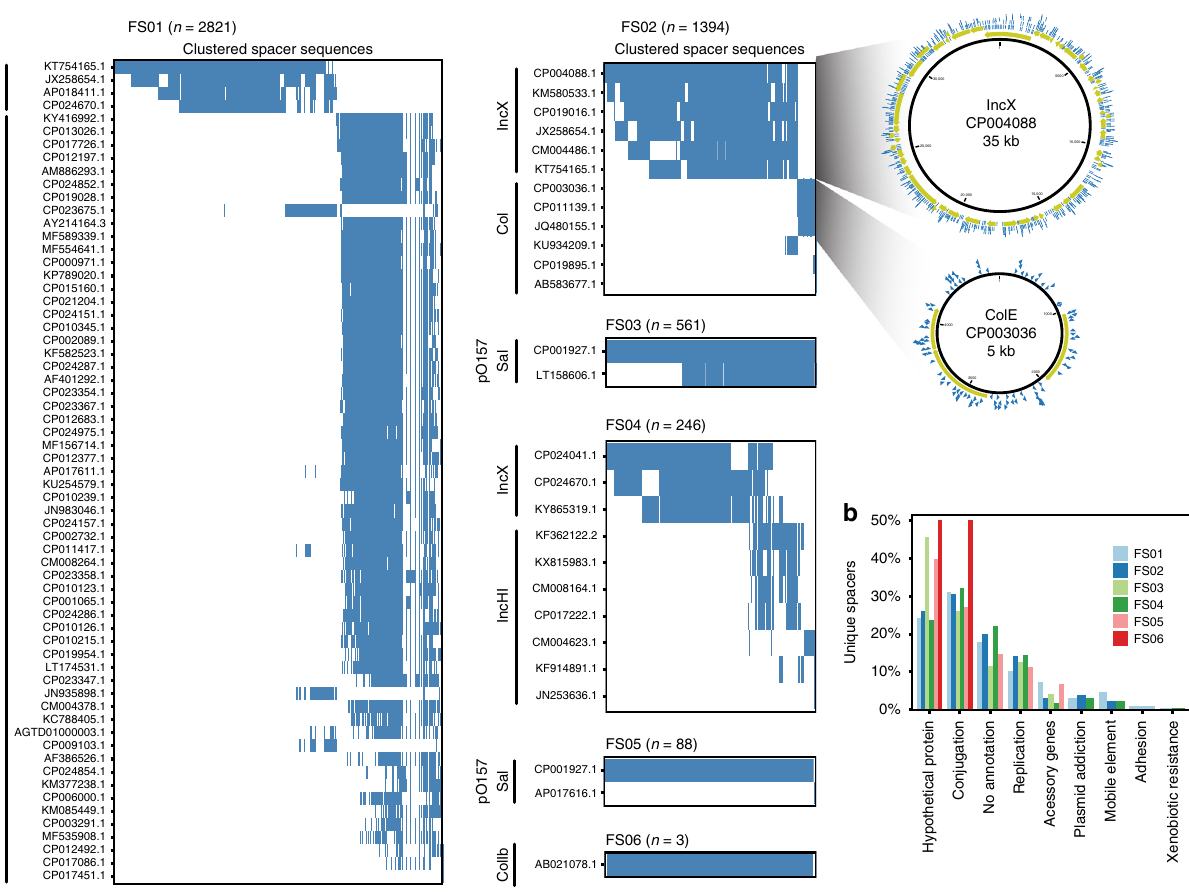
Fig. 5 Analysis of human-associated mobilome from HGT recordings. a Exogenous spacers mapped to the custom plasmid database, each row represents a plasmid (denoted by accession number). The mappings are fi ltered to include the fewest number of plasmids covering all spacers. Rows are sorted in order of the number of spacers that map to the plasmid. The sorting enables easy identi fi cation of discrete transferred elements. Each spacer cluster is annotated with the predicted plasmid group based on Plasmid Finder 36 . Spacer mapping is illustrated for FS02 showing the plasmid backbone with predicted open reading frames (ORFs) (yellow) and mapping unique spacers (blue). b Annotation categories overlapping with the spacers from all six clinical recordings. Genes predicted to be involved in conjugative transfer dominate, followed by unannotated genes and genes involved in plasmid replication. Notably, very few spacers overlap with genes involved in drug